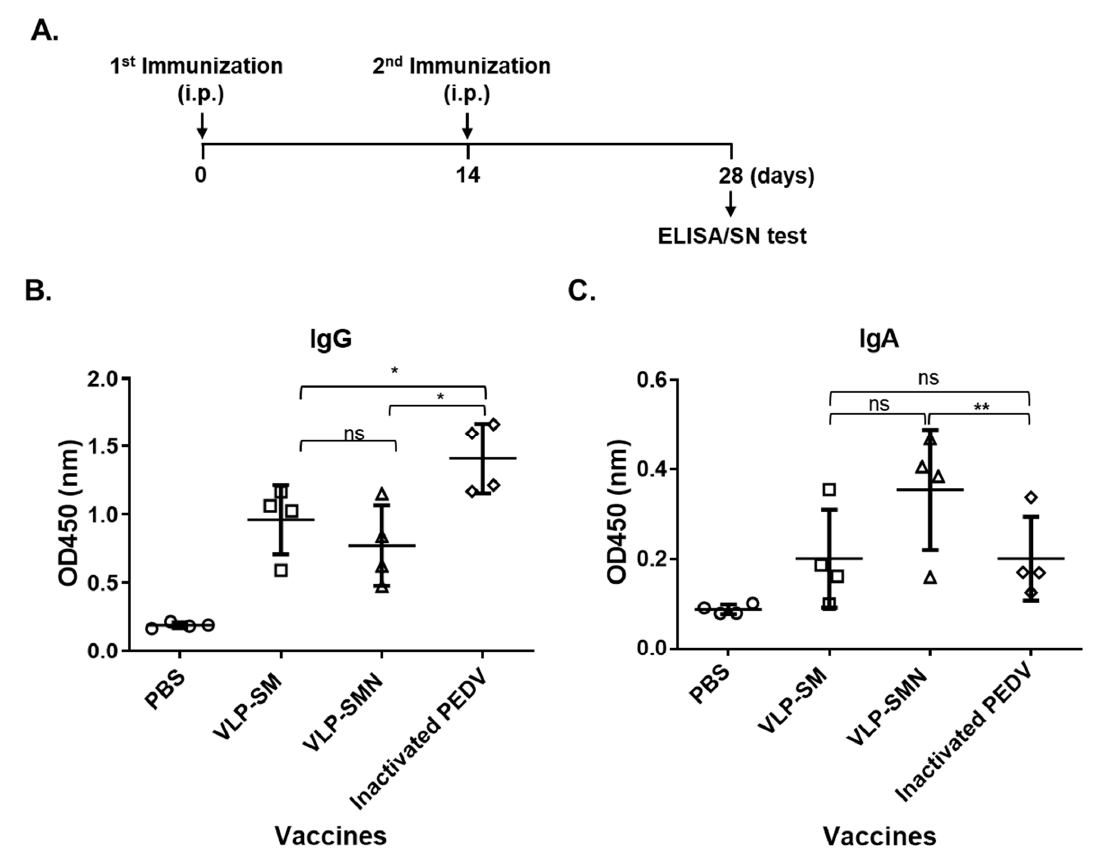
Figure 2. Humoral immune response induced by PED VLPs. ( A ) Schematic diagram of the immunization protocol. BALB/c mice were i.p. immunized with the indicated PED VLPs (square, triangle), UV-inactivated PEDV (diamond), or PBS (circle) at 0 and 14 days after the first immunization. At 28 days post-immunization, serum samples were collected. ( B , C ) The levels of PEDV-specific IgG ( B ) and IgA ( C ) were measured by ELISA. Results are expressed as the mean ( n = 3) at OD450 ± SD values and are representative of at least two independent experiments. Statistical significance was assessed using Student’s t -test. *, p < 0.05; **, p < 0.01; ns, not significant.